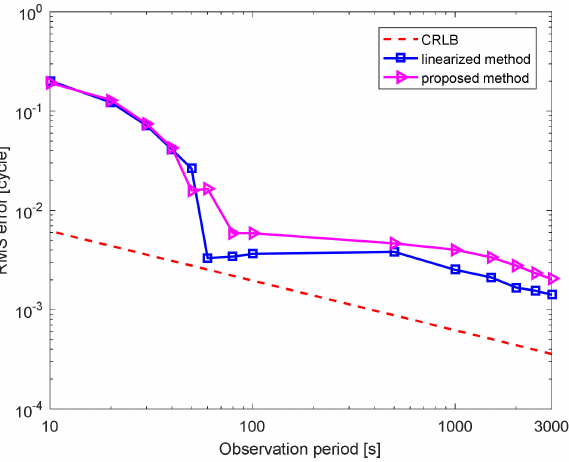
Figure 10. Pulse phase estimation results of the linearized method and the stellar angle measurement- aided phase estimation method.